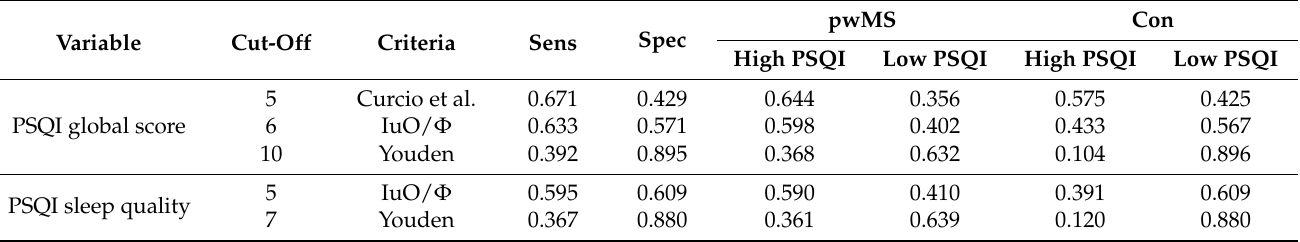
Table 8. Sensitivity (Sens), specificity (Spec), and proportions of patients with multiple sclerosis (pwMS) and the control group (Con) classified in the high/low PSQI group according to different cut-offs based on different